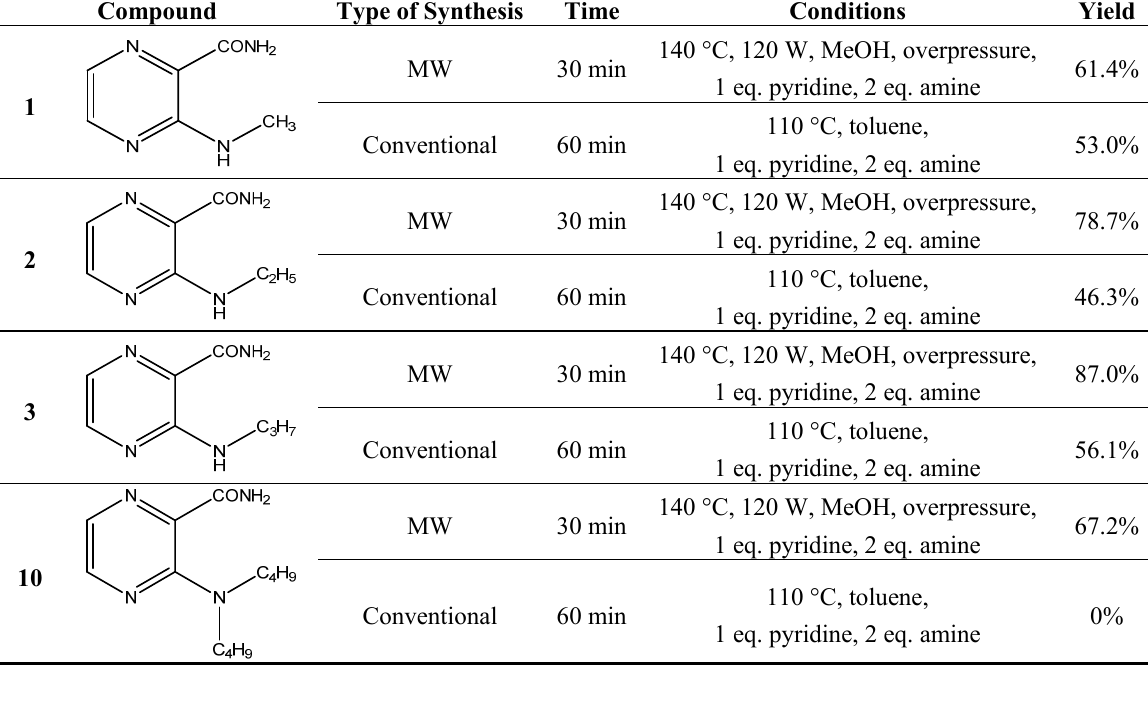
Table 2. List of prepared compounds and their